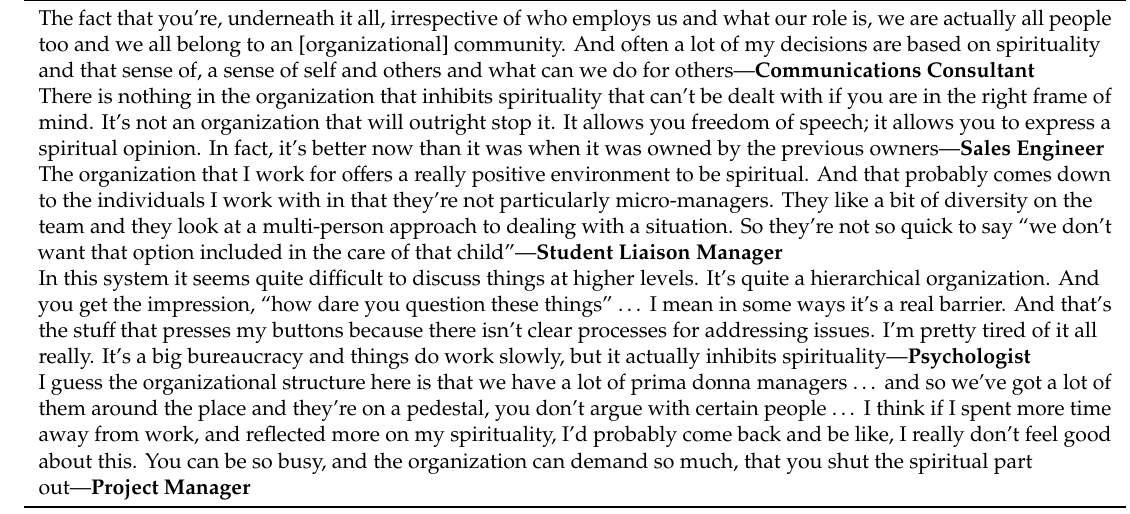
Table 3. Extracts in support of Condition 2— Provide More Autonomy